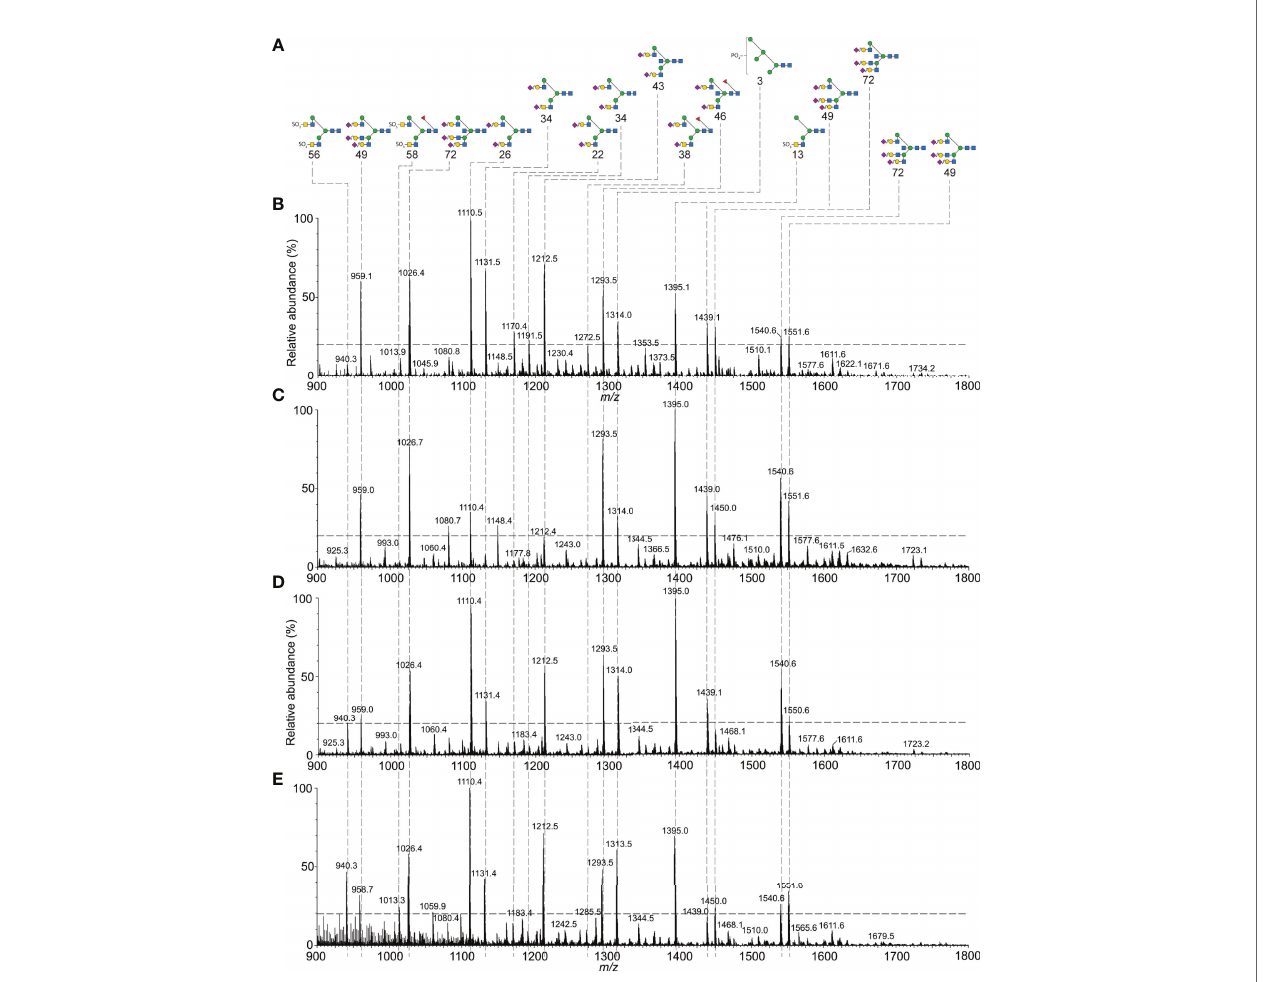
Figure 1 . Nano-ESI spectrum from Supplement Figure S1D . (C) FSHa Asn52 glycans from pituitary FSH24 glycoform fraction 12 (Figure S5B). (D) FSHa Asn52 glycans from FSH24/21/18 fraction 21 ( Figure S5C ). (E) FSHa Asn52 glycans from FSH18/21 fraction 30 ( Figure S5E